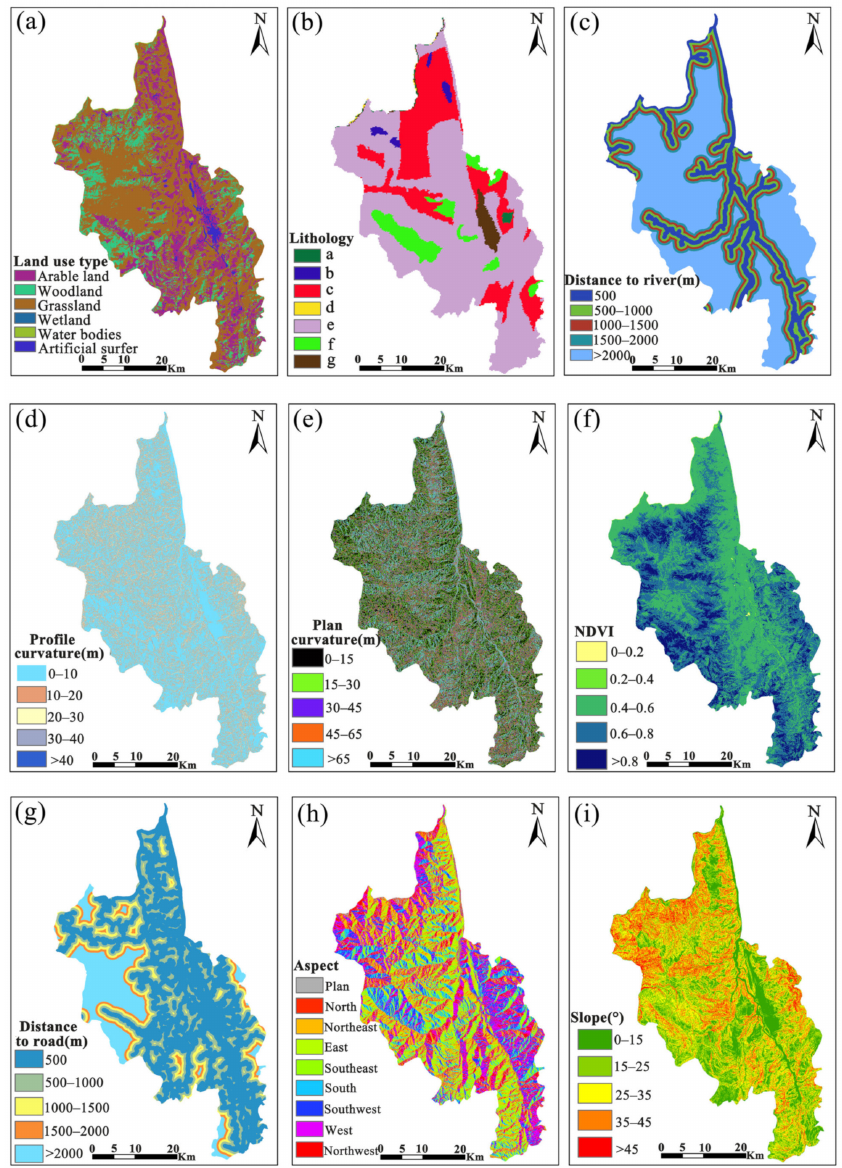
Figure 3. Classification chart of disaster-causing variables: ( a ) is the land use type, ( b ) is the lithology, ( c ) is the distance to a river, ( d ) is the profile curvature, ( e ) is the plan curvature, ( f ) is the NDVI, ( g ) is the distance to road, ( h ) is the aspect, and ( i ) is the slope. In ( b ), a represents acidic deep-formed rocks, b represents basaltic volcanic rocks, c represents carbonate sedimentary rocks, d represents neutral volcanic rocks, e represents mixed sedimentary rocks, f represents siliceous clastic sedimentary rocks, and g represents loose